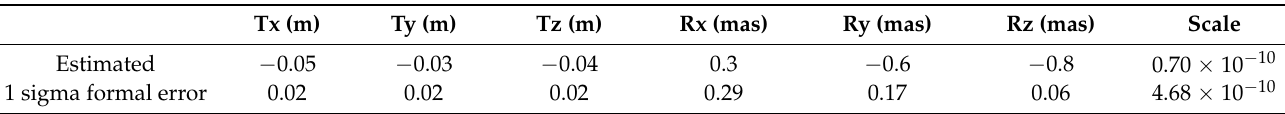
Table 2. Helmert parameters relating the origin, orientation and scale of the Broadcast reference frame of E01 relative to the IGS14 frame of the SP3 precise ephemeris, 2 January 2020.